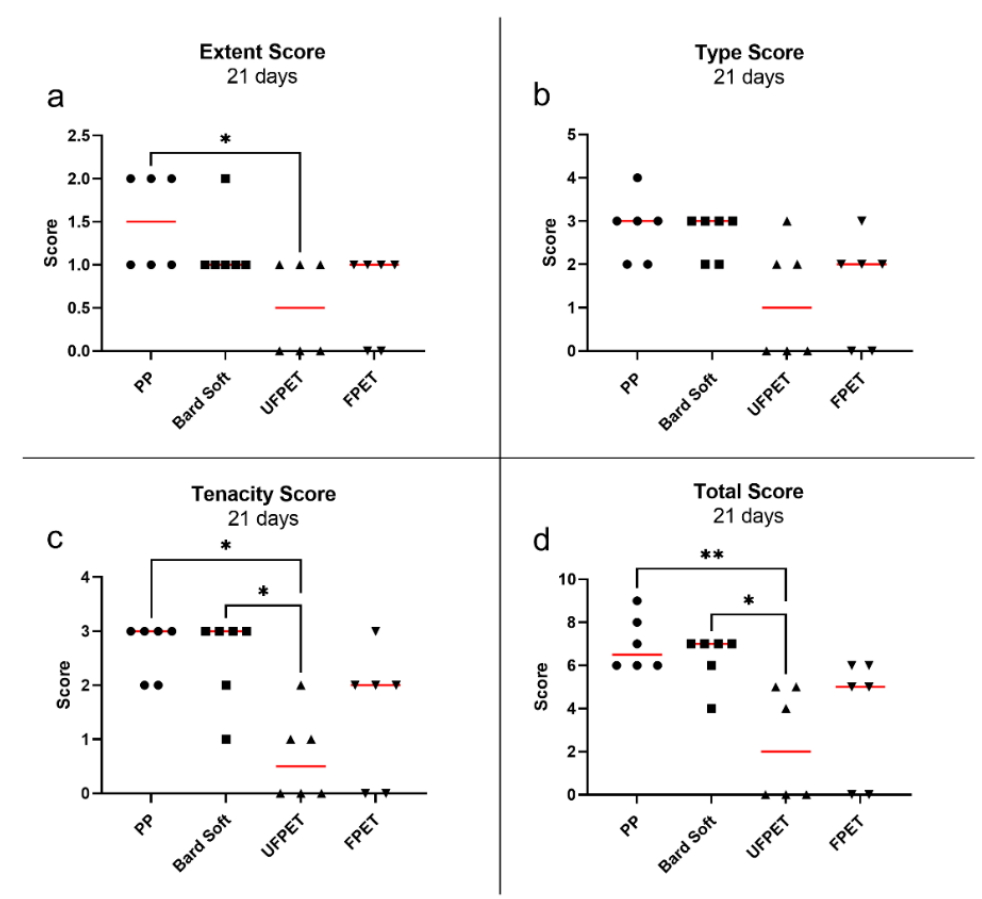
Figure 8. Scatter plot of Diamond adhesion scores after 7 days. Red bar denotes median. * p < 0.05 and ** p < 0.01. ( a ) Extent score, ( b ) Type score, ( c ) Tenacity score, ( d ) Total score.